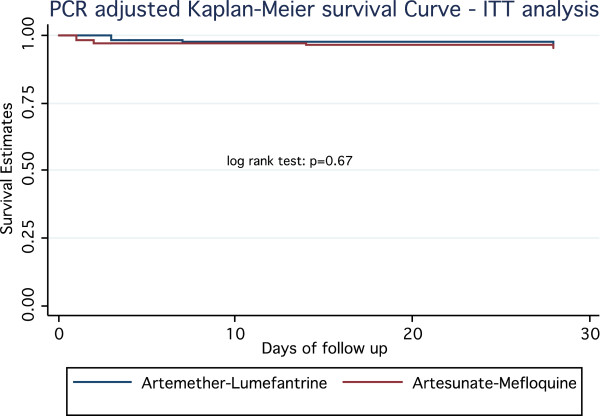
Kaplan Meir survival estimates of PCR adjusted ACPR by treatment arm – ITT analysis.